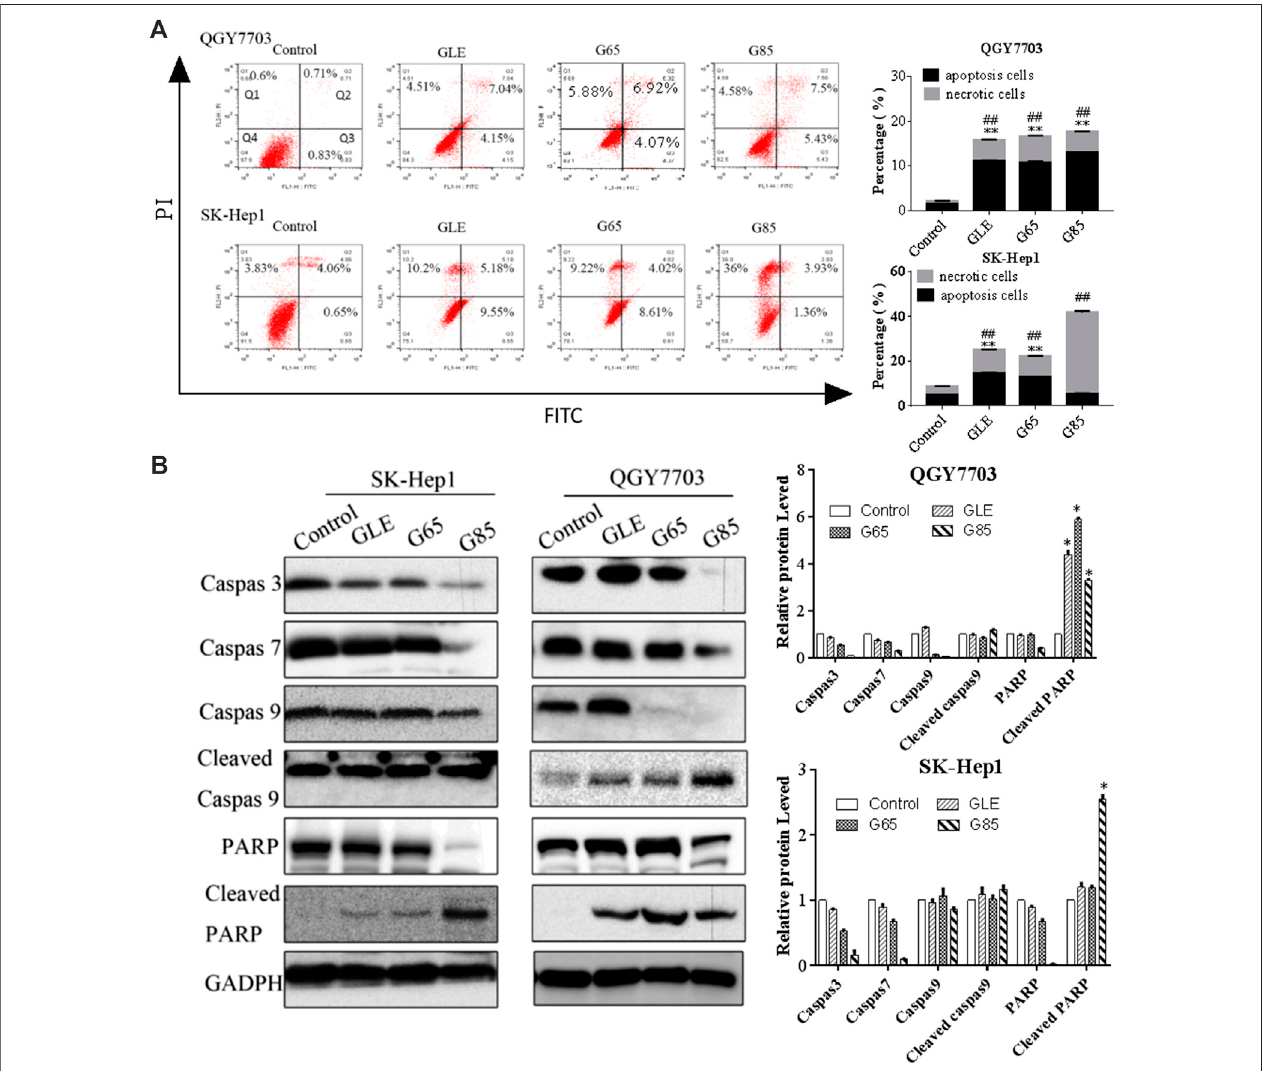
FIGURE 5 | Effect of G. lucidum extracts on QGY7703 and SK-Hep1 cells apoptosis. (A) QGY7703 and SK-Hep1 cells were treated with GLE, G65 and G85 (150 μ g/ml)for24 handanalyzedforapoptoticandnecroticcelldeathusinganAnnexin-V:FITCApoptosisDetectionKit. (B) QGY7703andSK-Hep1cellsweretreated with GLE, G65, G85 (150 μ g/ml) for 48 h. The expression of Caspase 9, 3, and 7, PARP, cleaved Caspase 9 and cleaved PARP were determined by western blot. Data were shown as mean ± SD. * p < 0.05 (cleaved PARP),** p < 0.01 (apoptosis rate), ## p < 0.01 (necrosis rate), vs control.